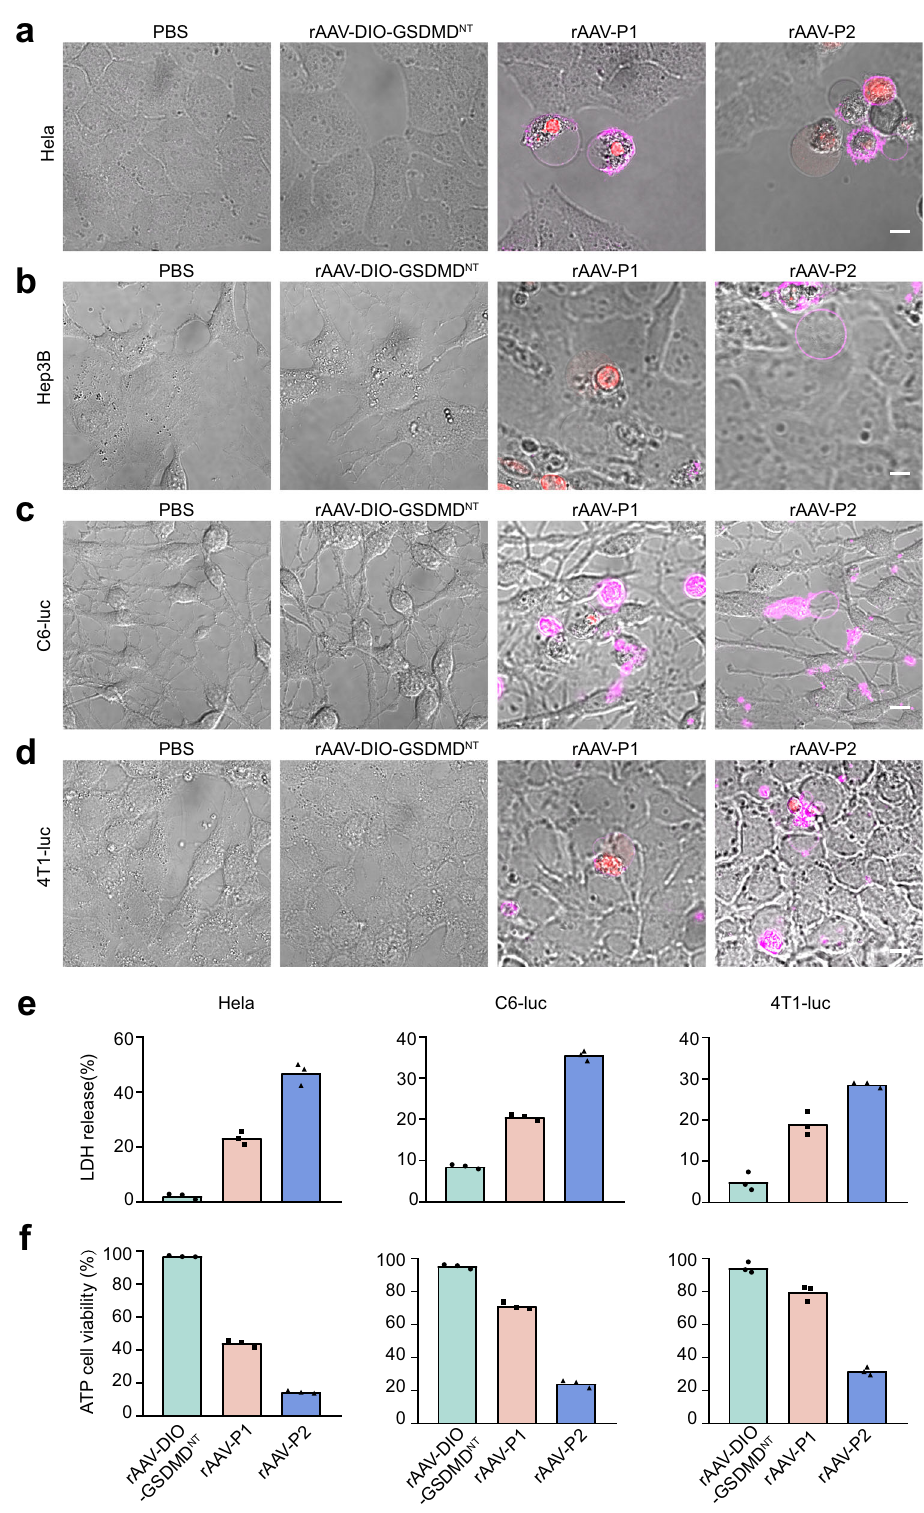
Fig. 2 The pyroptosis induced by rAAV-P1 and rAAV-P2 in different cancer cell lines. a – d Confocal images of the rAAV-treated HeLa ( a ), Hep3B ( b ), C6-luc ( c ), and 4T1-luc ( d ) cells. Scale bars, 20 μ m. All the cells were added with propidium iodide and Annexin V-APC 15 min before imaging. e , f Comparison of LDH release-based cell death assay ( e ) and ATP cell viability assay ( f ) in HeLa, C6-luc, and 4T1-luc cells after treatment with rAAV- DIO-GSDMD NT (rAAV-ef1 α -DIO-GSDMD NT ), rAAV-P1, and rAAV-P2, respectively. All data are representative of three independent experiments. Source data are provided as a Source Data fi